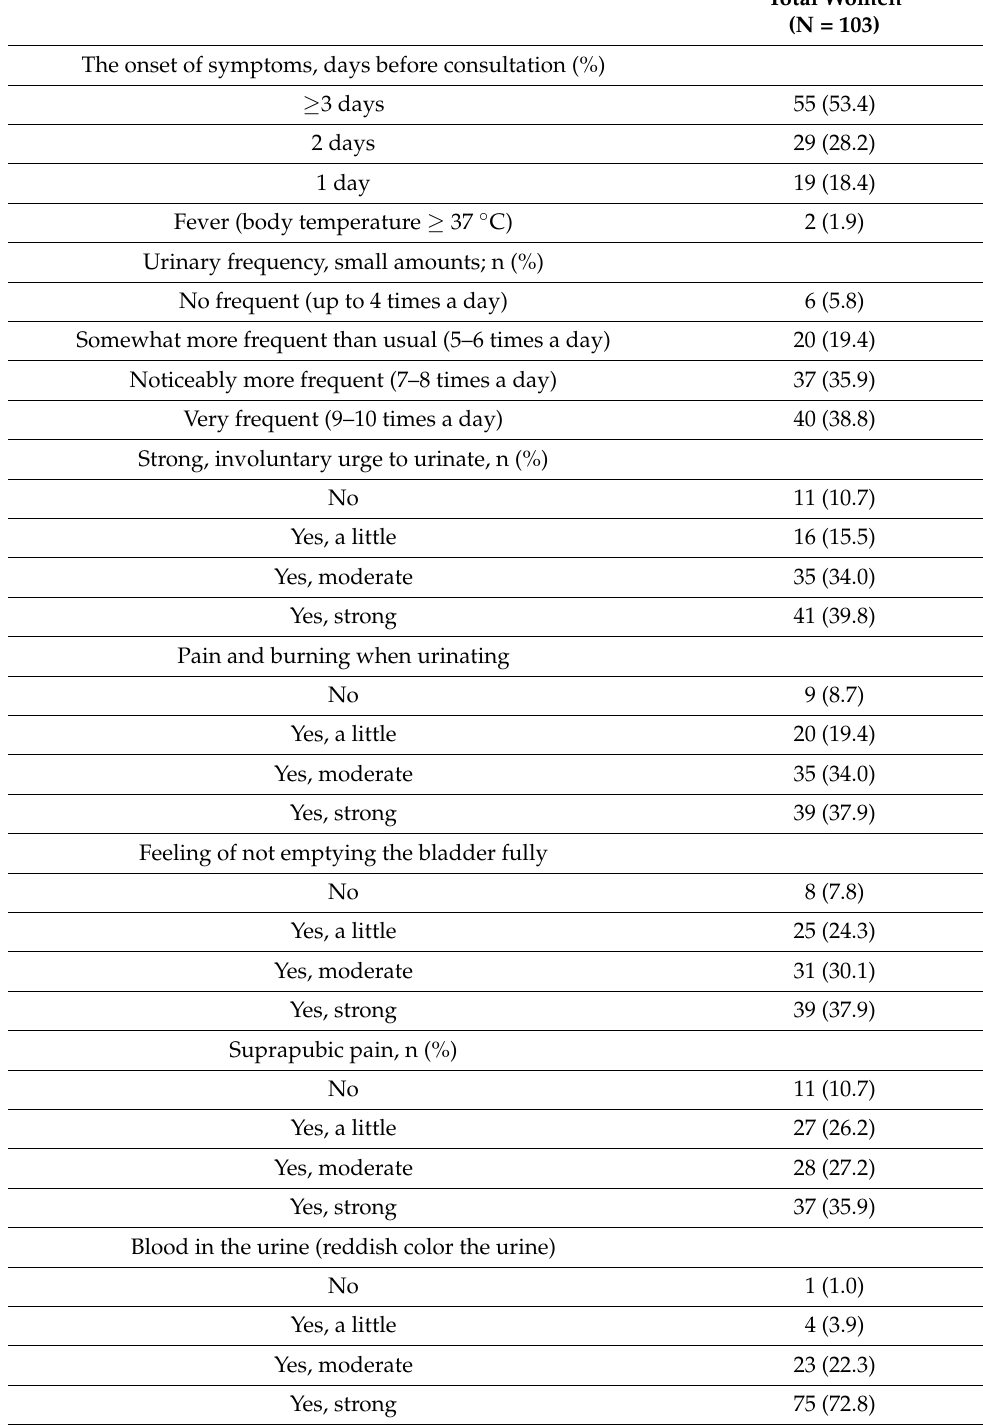
Table 2. Characteristics of episodes with acute uncomplicated cystitis-like